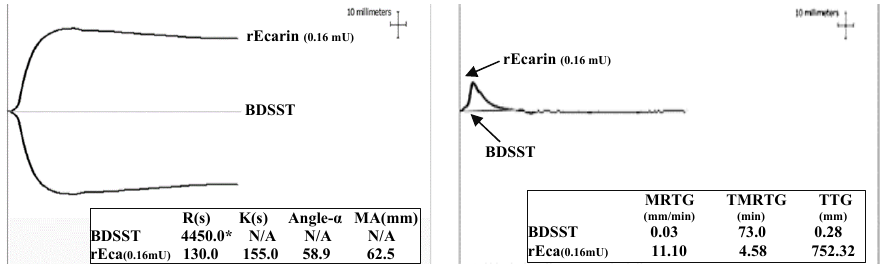
( B ). TEG characteristics of blood from a warfarin patient in a BDSST tube compared to rEcarin in a BD plain tube